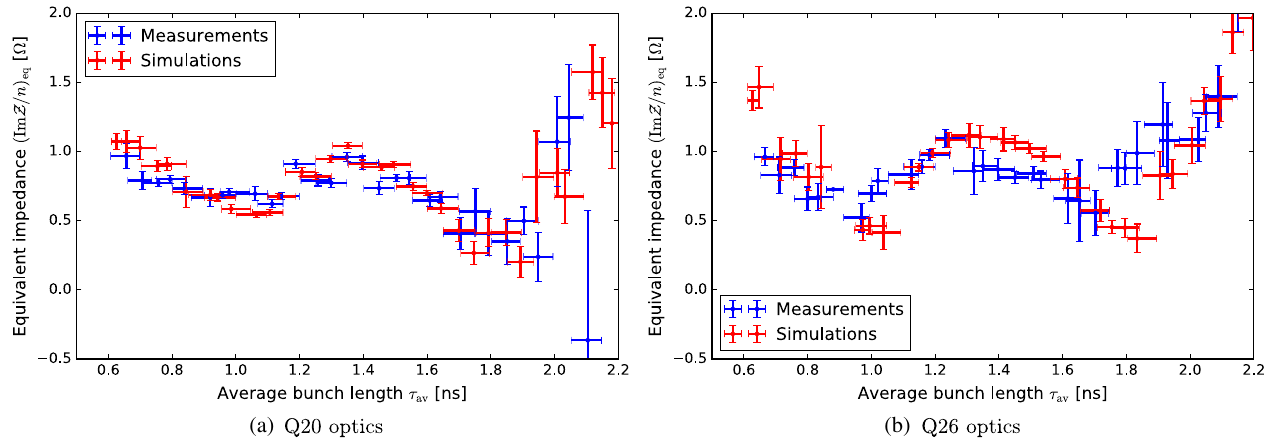
FIG. 18. Equivalent impedance ð Im Z =n Þ in measurements and simulations after adding an extra resonator with f r ¼ 350 MHz, eq R=Q ¼ 3 k Ω and Q ¼ 1 to the SPS impedance model to compensate for deviations from measurements in both Q20 (left) and Q26 (right)